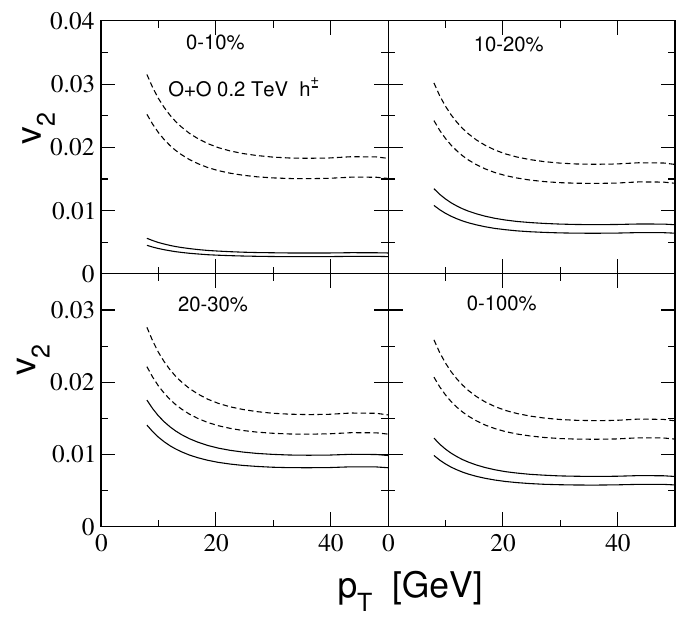
Figure 12 . v 2 of charged hadrons in 0 . 2 TeV O+O collisions for τ 0 = 0 . 5 for the initial fireball eccentricity (cid:15) 2 calculated in the optical (solid) and Monte-Carlo (dashed) Glauber model for sce- narios without and with (bottom to top) mQGP formation in pp